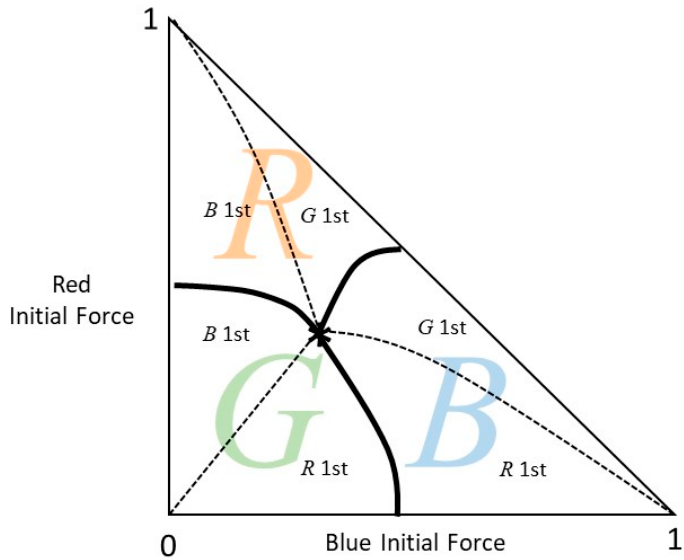
Figure 2. Winning regions. The solid curves represent points of mutual annihilation at the second stage by the two adjacent players, while the dotted lines indicate points of mutual annihilation at the first stage.